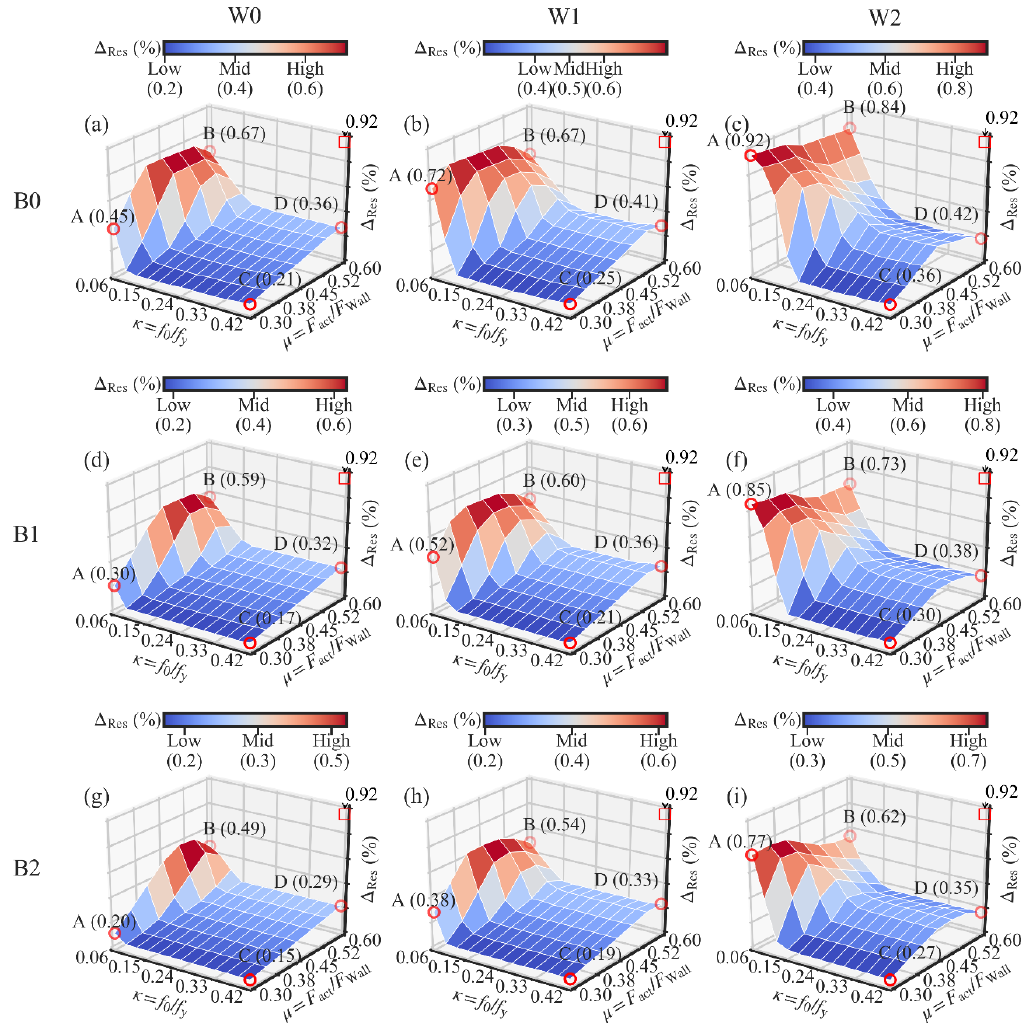
Figure 14. Three-dimensional surfaces of the residual drift: ( a ) W0B0; ( b ) W1B0; ( c ) W2B0; ( d ) W0B1;